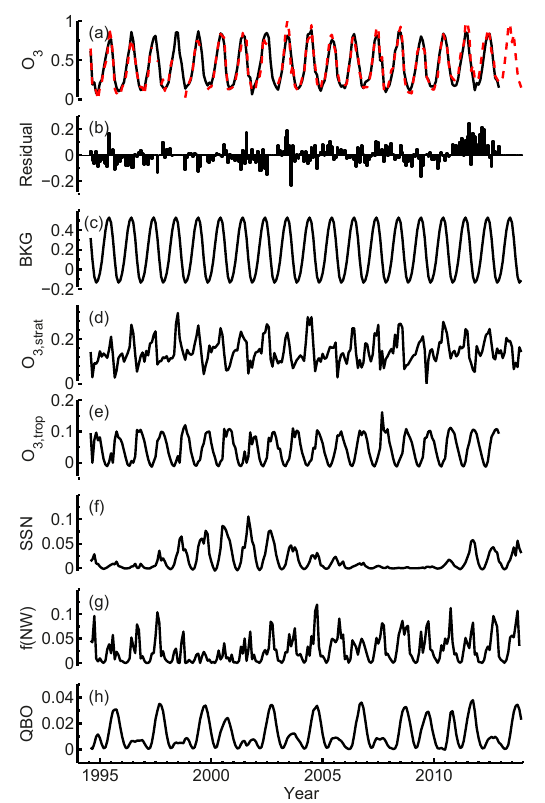
Figure 18. Temporal variation in the (a) normalised observed and fitted ozone concentration, (b) the residual of the regression, the contribution of (c) a background factor and five influencing factors to the ozone regression: (d) the modelled O 3 Strat, (e) the contribu- tion of tropospheric ozone transport O 3 , trop , (f) the sunspot number, (g) the frequency of northwesterly trajectories, and (h) the QBO in-